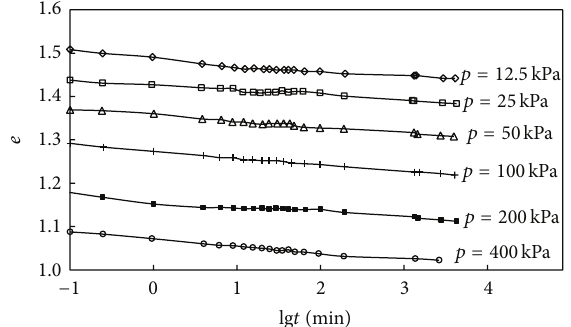
Figure 2: Tested 𝑒 -lg 𝑡 curves of soft soil sample No. 1.